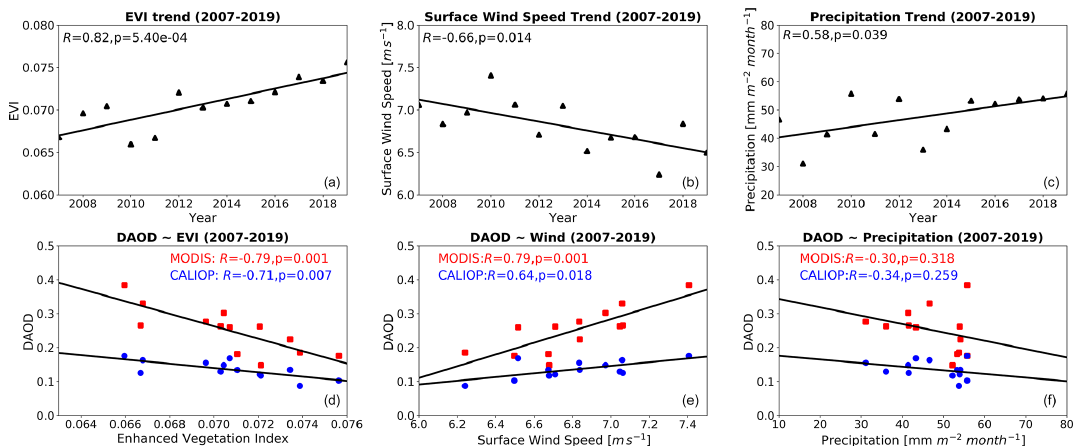
Figure 18. The trend of Enhanced Vegetation Index (EVI), surface wind speed, and precipitation and their correlation with DAOD in spring in the EAS-5 region. Panels (a) – (c) show the trend of EVI, surface wind speed, and precipitation. Panels (d) – (f) show the correlation of EVI, surface wind speed, and precipitation with MODIS-based DAOD and CALIOP-based DAOD, respectively. In addition, the time series of EVI versus DAOD, wind speed versus DAOD, and precipitation versus DAOD is shown in Fig.